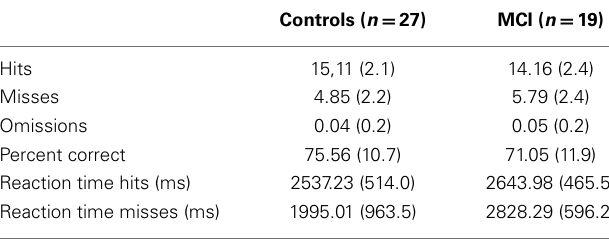
Table 3 | fMRI recognition performance